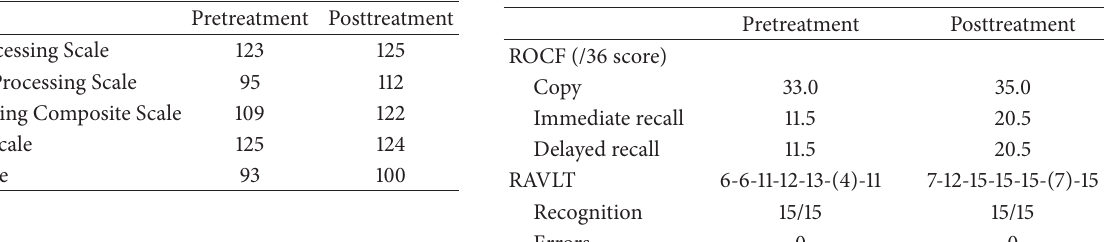
Table 2: Kaufman Assessment Battery for children (K-ABC) before and after treatment.